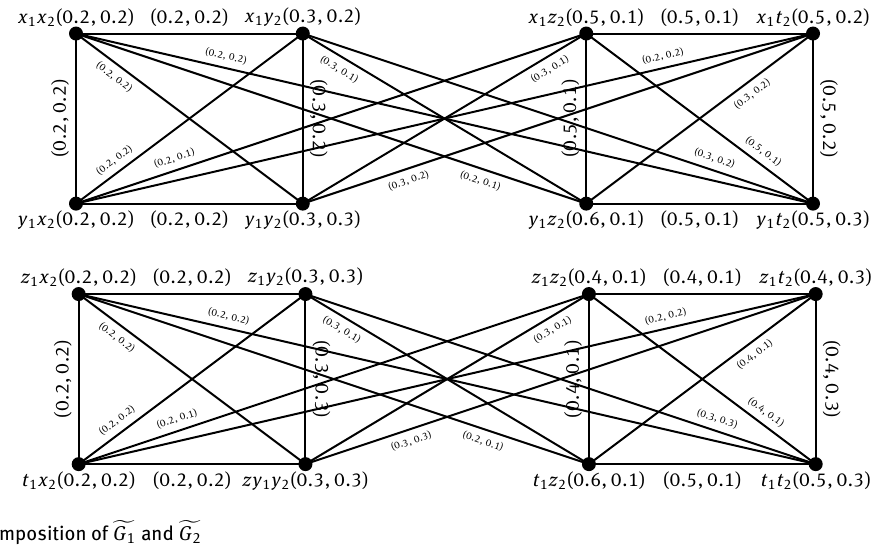
Figure 7: Composition of (cid:102) G 1 and (cid:102) G